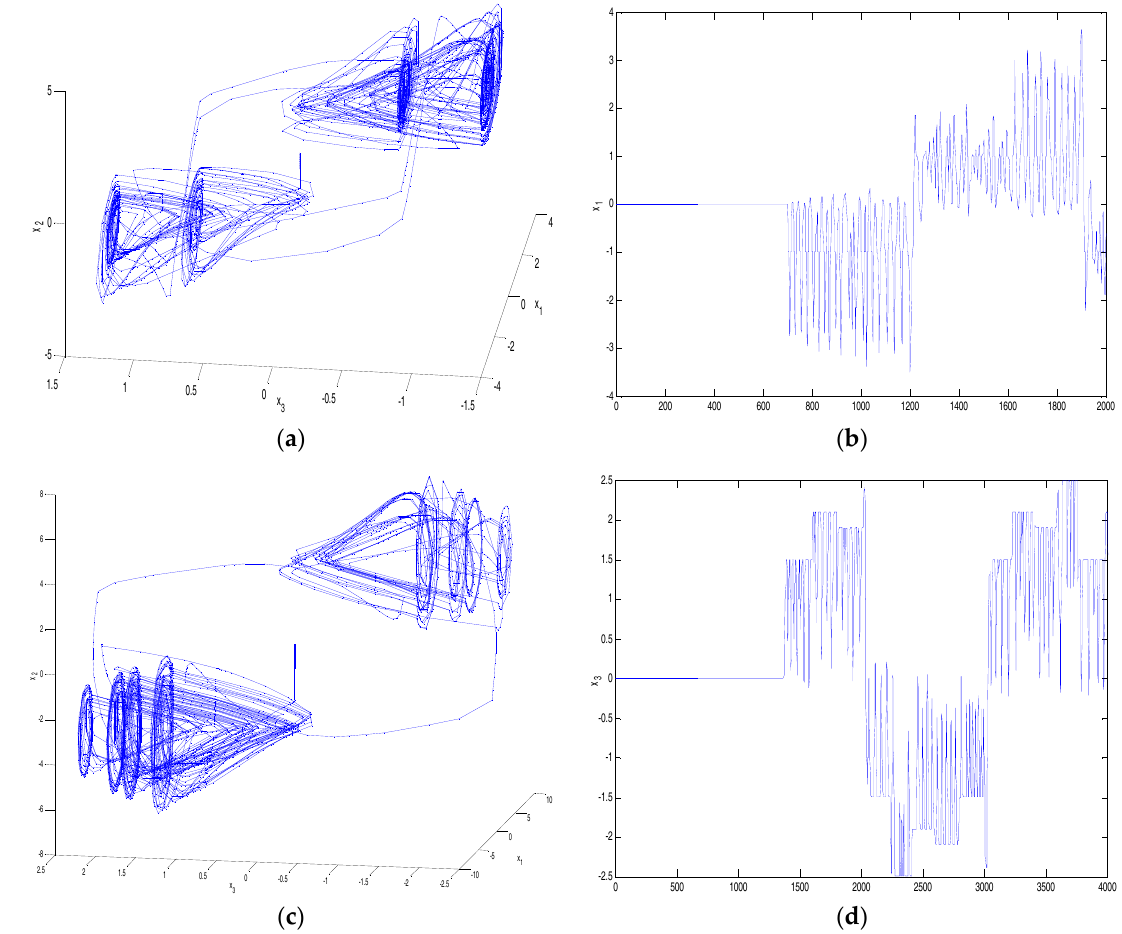
Figure 11. Numerical results of the 3 ‐ D multi ‐ scroll attractors ‐ II: ( a ) 2 ‐ double scrollin x 1 ‐ x 2 ‐ x 3 plane; ( b ) variable x 1 (t); ( c ) 4 ‐ double scrollin x 1 ‐ x 2 ‐ x 3 plane; and ( d ) variable x 3 (t). 4.3.3. 3 ‐ D Multi ‐ Scroll Attractors along x 3 ‐ x 1 ‐ x 2 Directions: